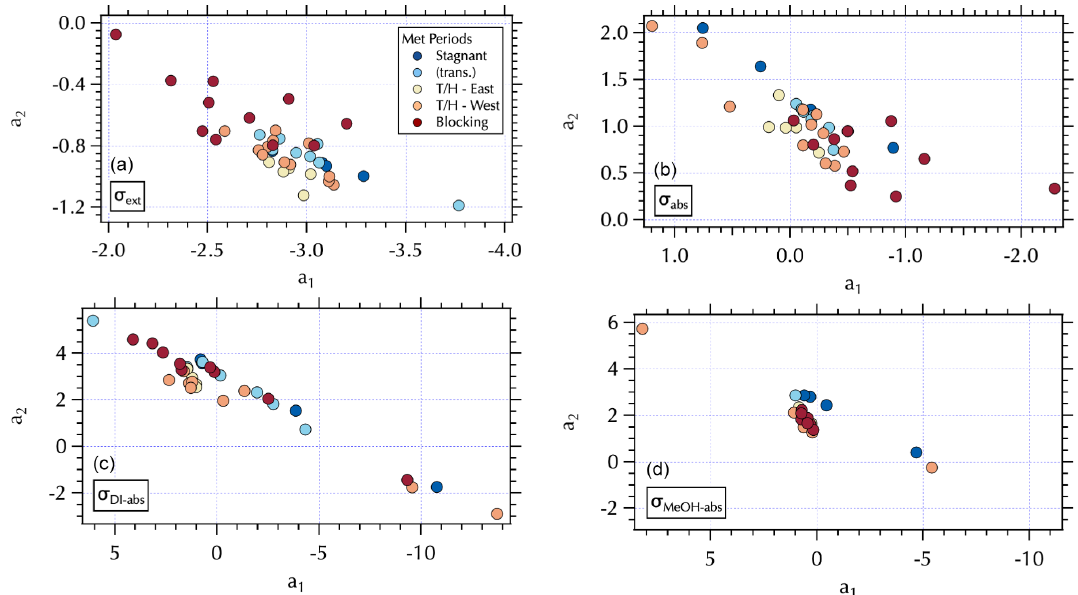
Figure 8. Maps of the meteorological groups as in Fig. 1 in a 2 vs. a 1 space: σ ext (a) , σ abs (b) , σ DI-abs (c) , and σ MeOH-abs (d) .